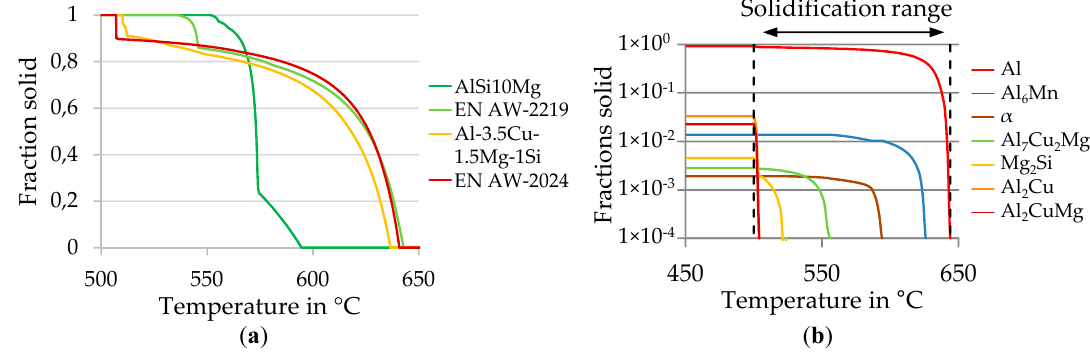
Figure 2. ( a ) Solidification path of different Al–Cu alloys compared to AlSi10Mg ( b ) Phase forming during solidification in EN AW-2024. Calculated with JMatPro 10.4.